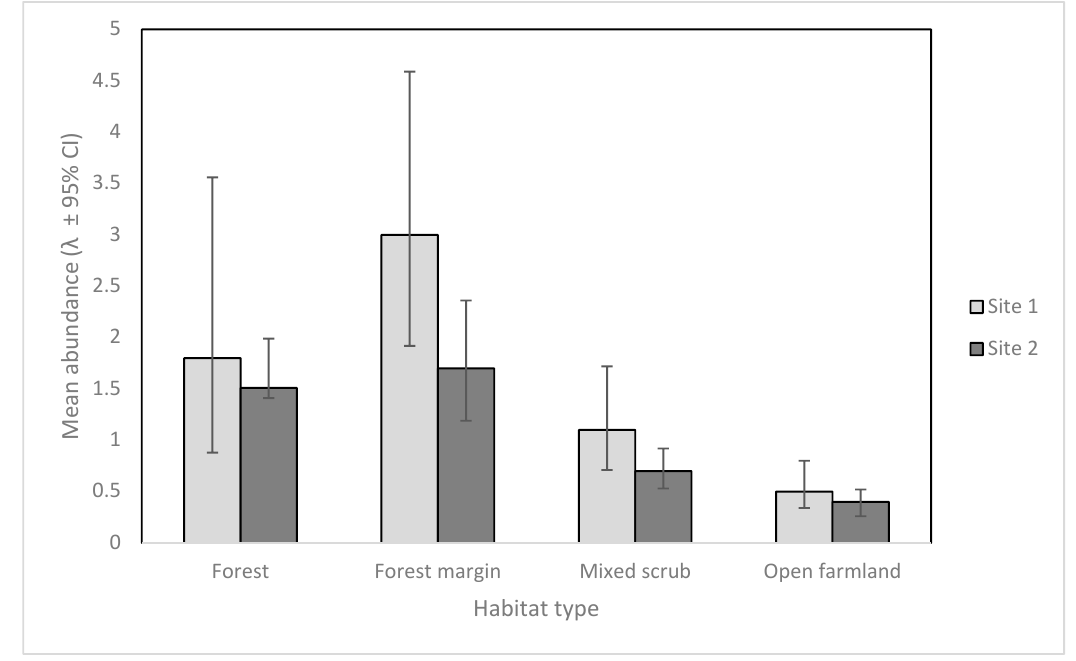
± 95% CI) at Site 1 and Site 2.